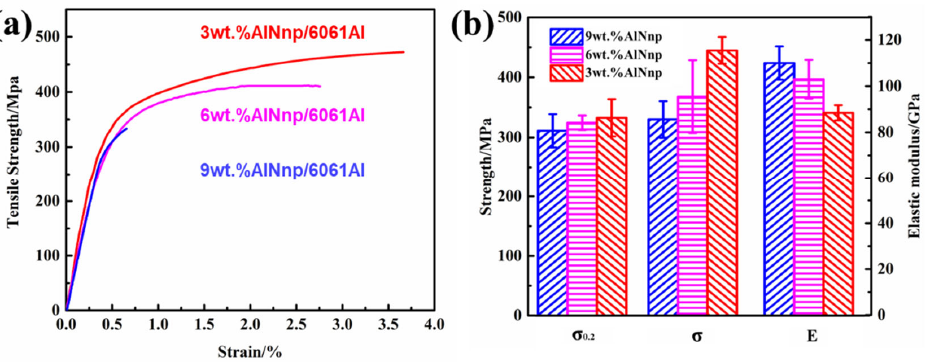
Figure 10. Stress–strain curves of nano-AlN/AA6061 composites: ( a ) Tensile curve; ( b ) Comparison of yield strength, tensile strength, and elastic modules.